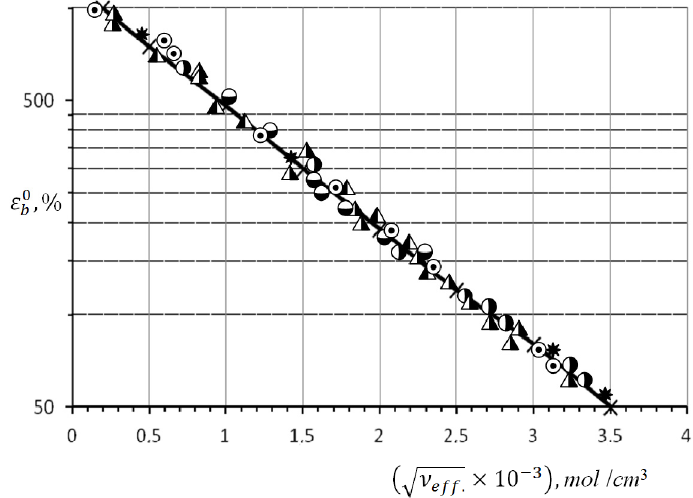
Figure 1: Experimental dependence